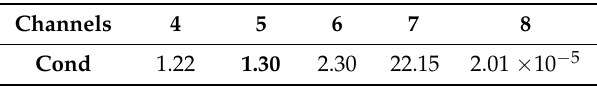
Table 7. Condition number of the No.16 series.